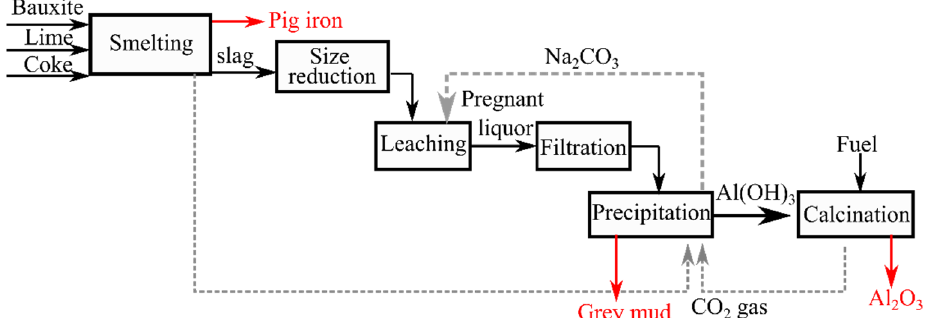
Figure 1. A simplified process flow of the Pedersen process, the stream by-products are highlighted in red color.